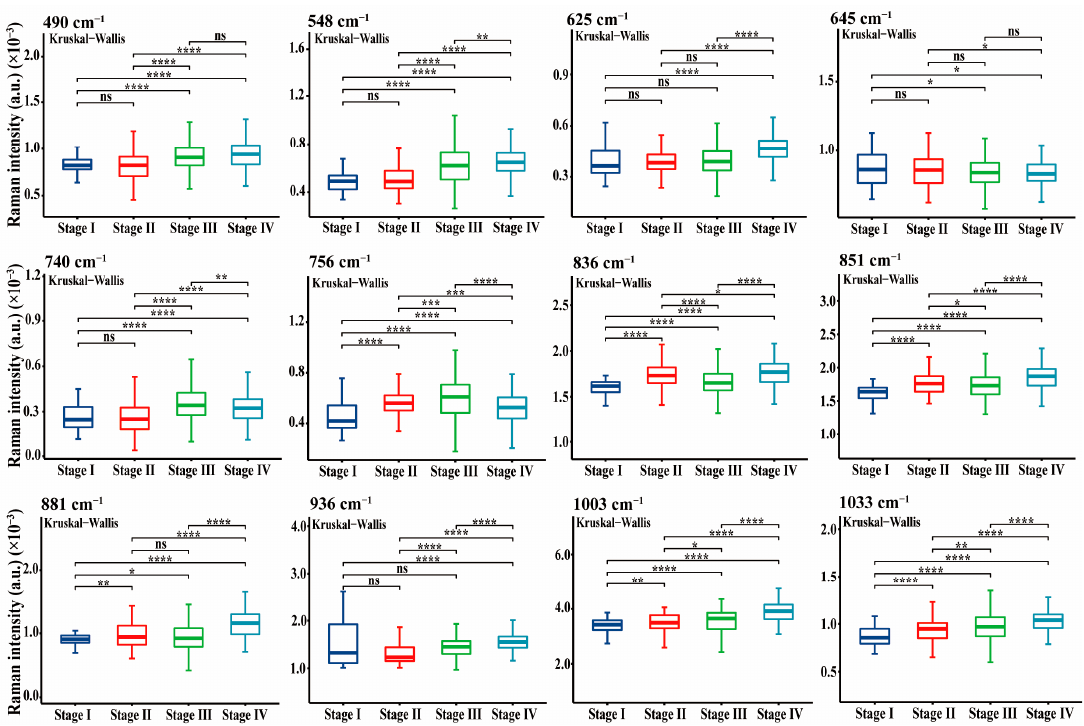
Figure 5. Box plots of some of the protein SERS peak intensities for NPC subjects at each of the four stages. Abbreviations: ns indicates no significance; * p < 0.05; ** p < 0.01; *** p < 0.001; **** p < 0.0001 (Kruskal–Wallis test).